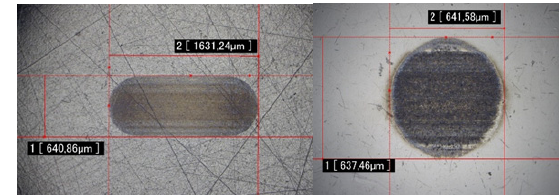
Figure 9:Wear photos of specimens used in the measure– ment with 0 km ran, used oil: ball on the left and disc on the right